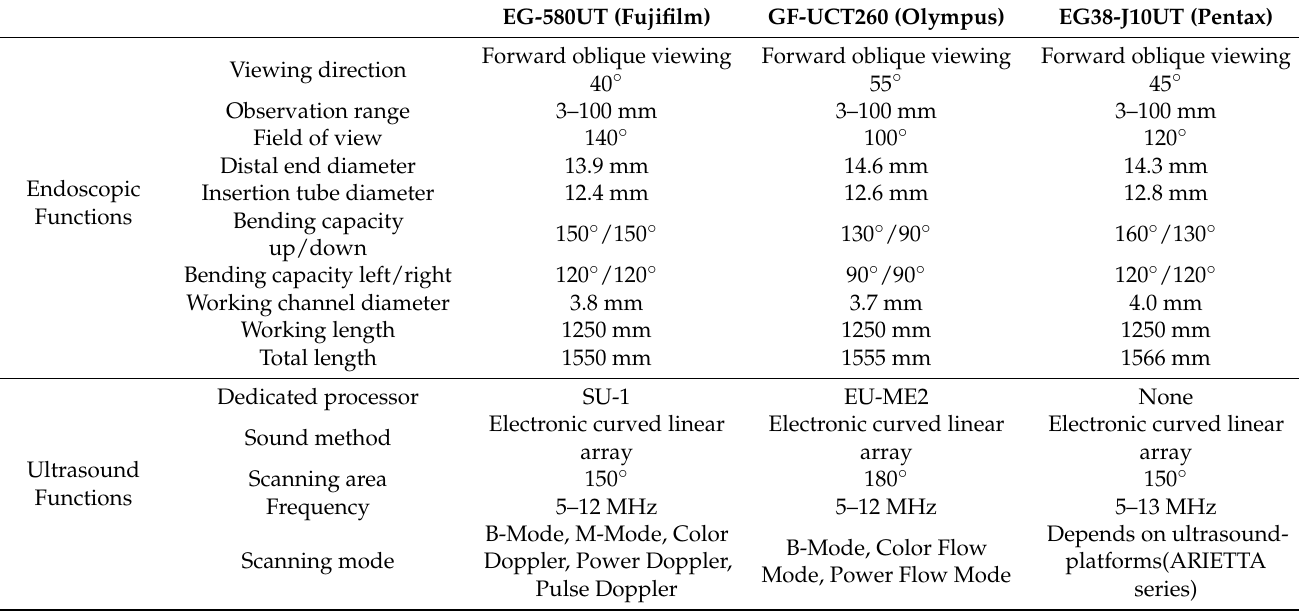
Table 1. Specifications of endoscopic ultrasound systems.